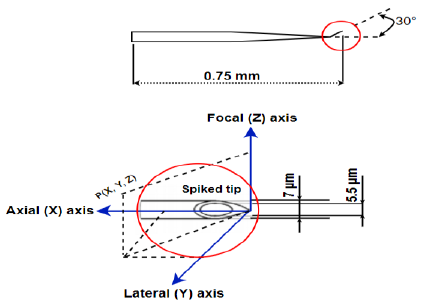
Figure 2. The dimensions of the injection pipette and its schematic 3D view.